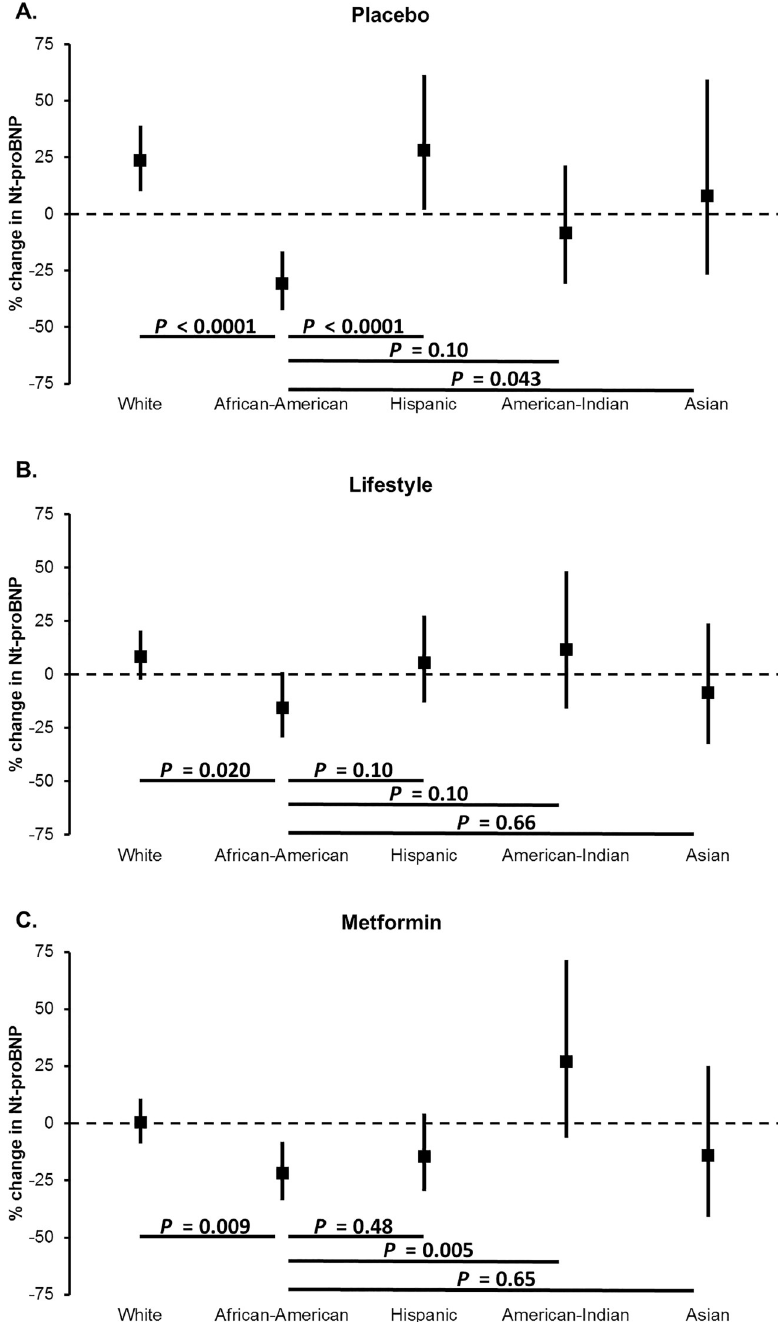
Fig 3. Multivariable adjusted percent change in NT-proBNP levels from baseline to two year follow up according to treatment randomization and race/ethnicity in the DPP. Percent change in NT-proBNP values (95% confidence interval) calculated from multivariable linear regression adjusted for: age, gender, body mass index, systolic blood pressure, diastolic blood pressure, history of hypertension, insulin sensitivity, estimated glomerular filtration rate, education and income, and NT-proBNP measured at baseline, as well as change in body mass index, change in insulin sensitivity, change in estimated glomerular filtration rate at 2 years of follow-up. ANCOVA P < 0.05 considered statistically